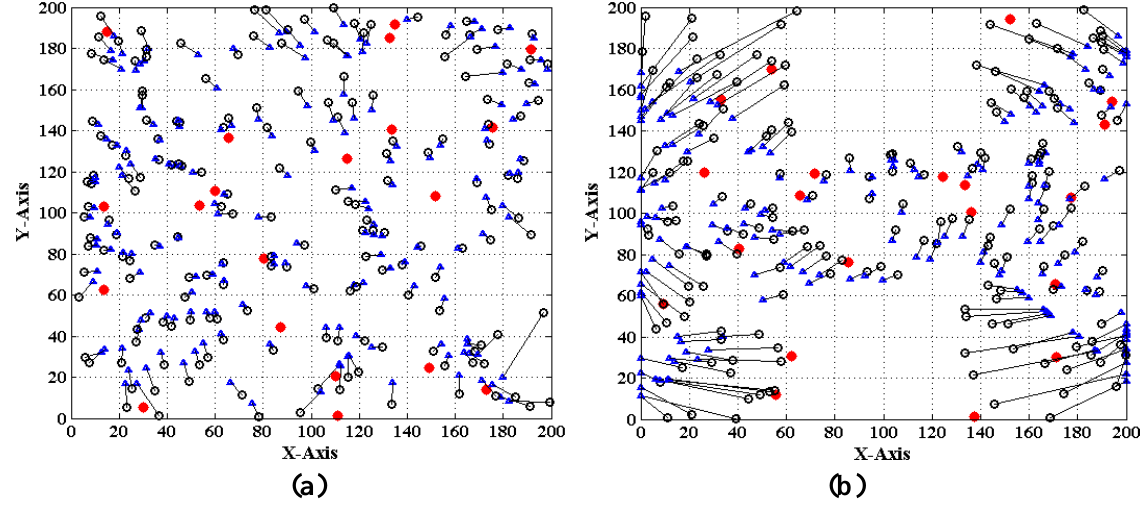
Figure 23. Localization results of MDS-MAP. (a) Isotropic network. (b) Anisotropic network.